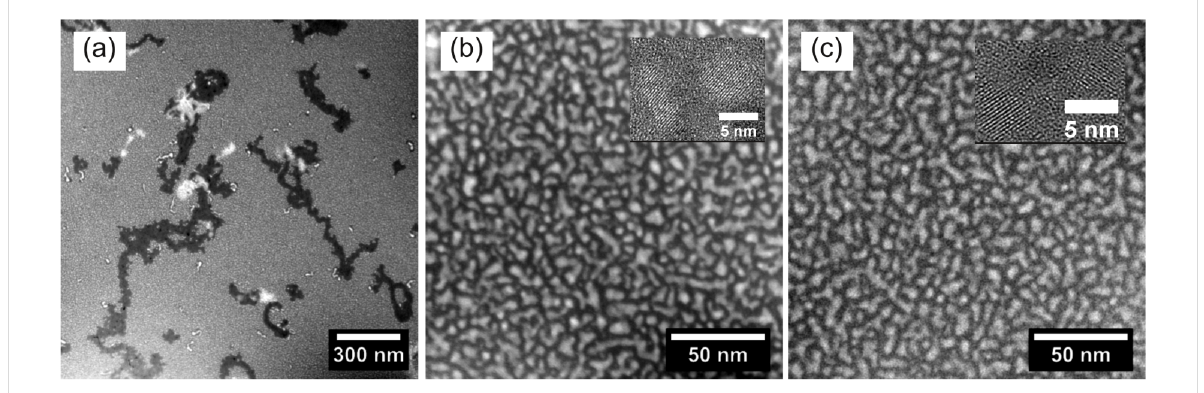
Figure 3: EFTEM images of S4 (a,b) and S5 (c): (a) overview image of S4 illustrating severe sample damage caused by Ar annealing, (b,c) smaller area to show that the morphology in the undamaged regions are fairly similar for both Ar and N 2 annealing.